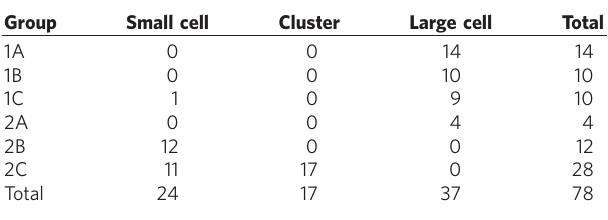
Table 2 | Details of sample type in each group.